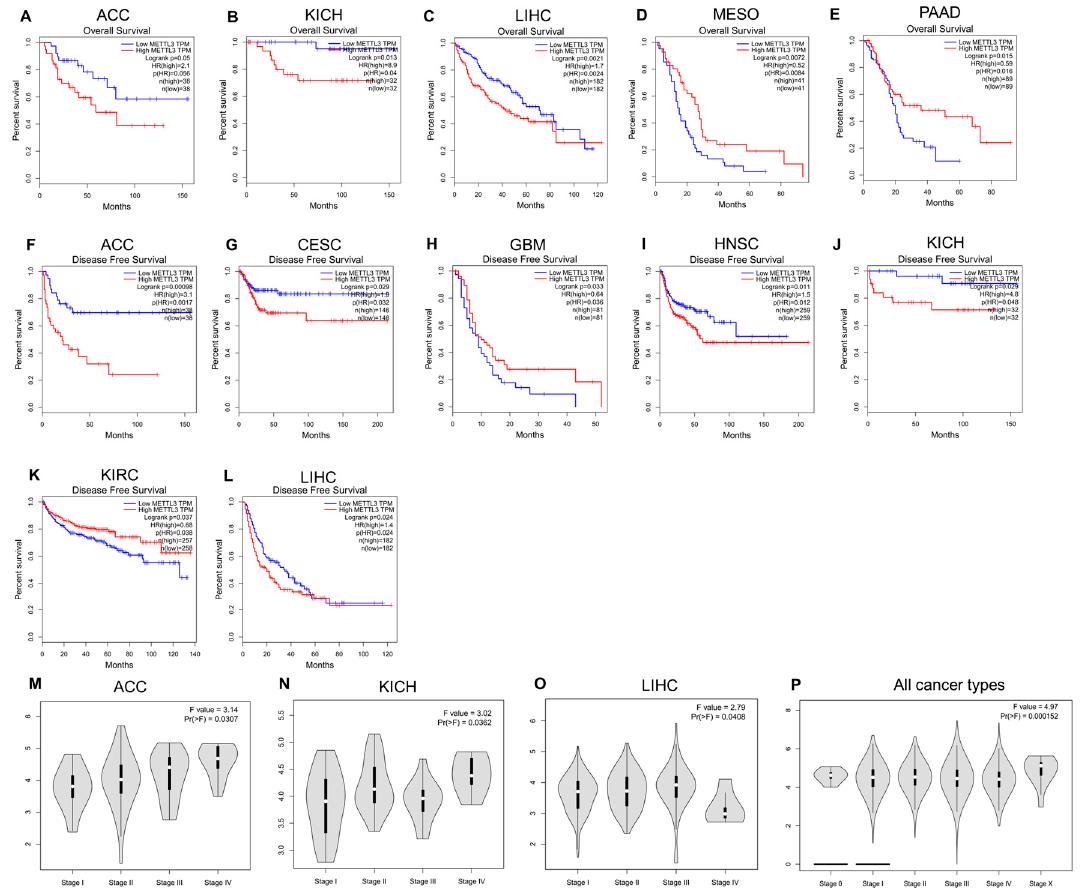
Figure 2. ( A – E ) Association between METTL3 expression levels and overall survival of patients with ACC, KICH, LIHC, MESO and PAAD. ( F – L ) Association between METTL3 expression levels and disease-free survival (DFS) of patients with ACC, CESC, GBM, HNSC, KICH, KIRC and LIHC. ( M – P ) Association between METTL3 expression levels and tumor stages of patients with ACC, KICH, LIHC and